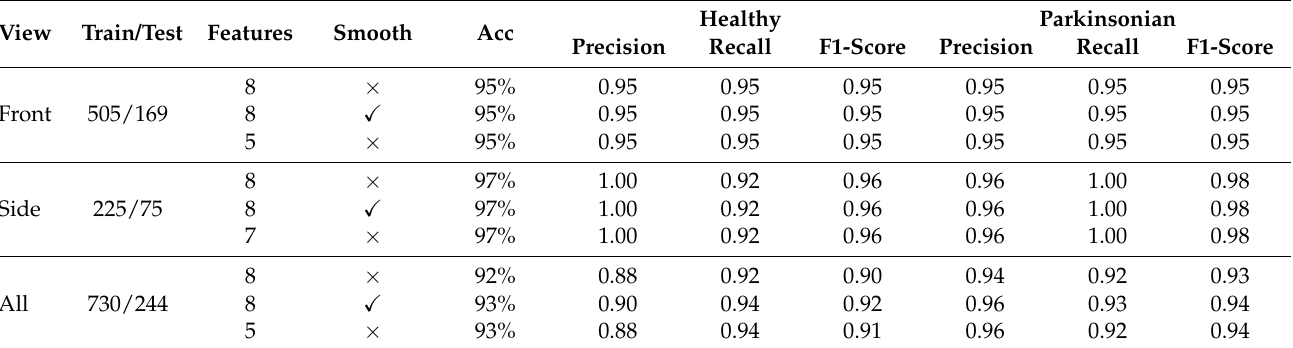
Table 4. Results summary of PD